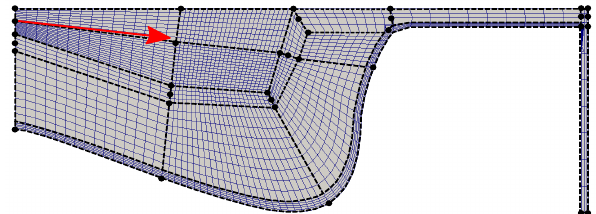
Figure 5. Mesh generator: control points and block definition.